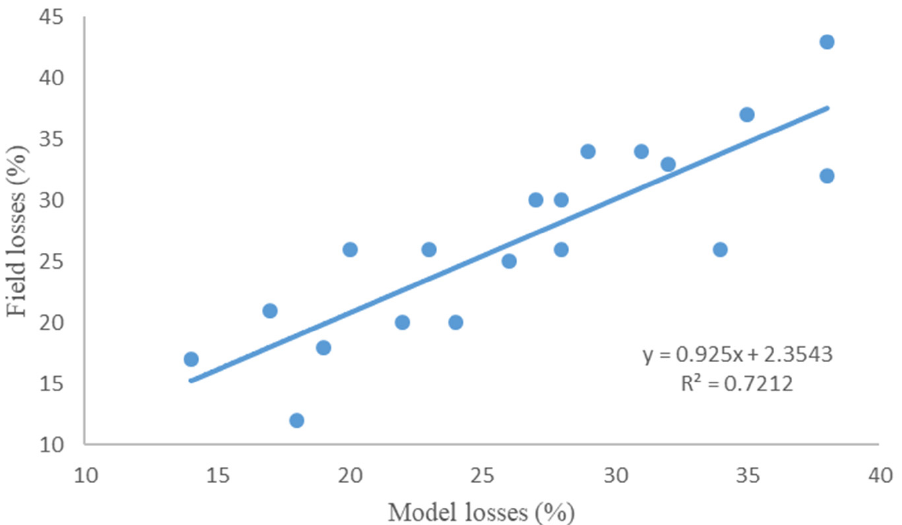
Figure 6. Comparison of the field-registered platform losses versus the model-predicted losses on a 20-point validation set.